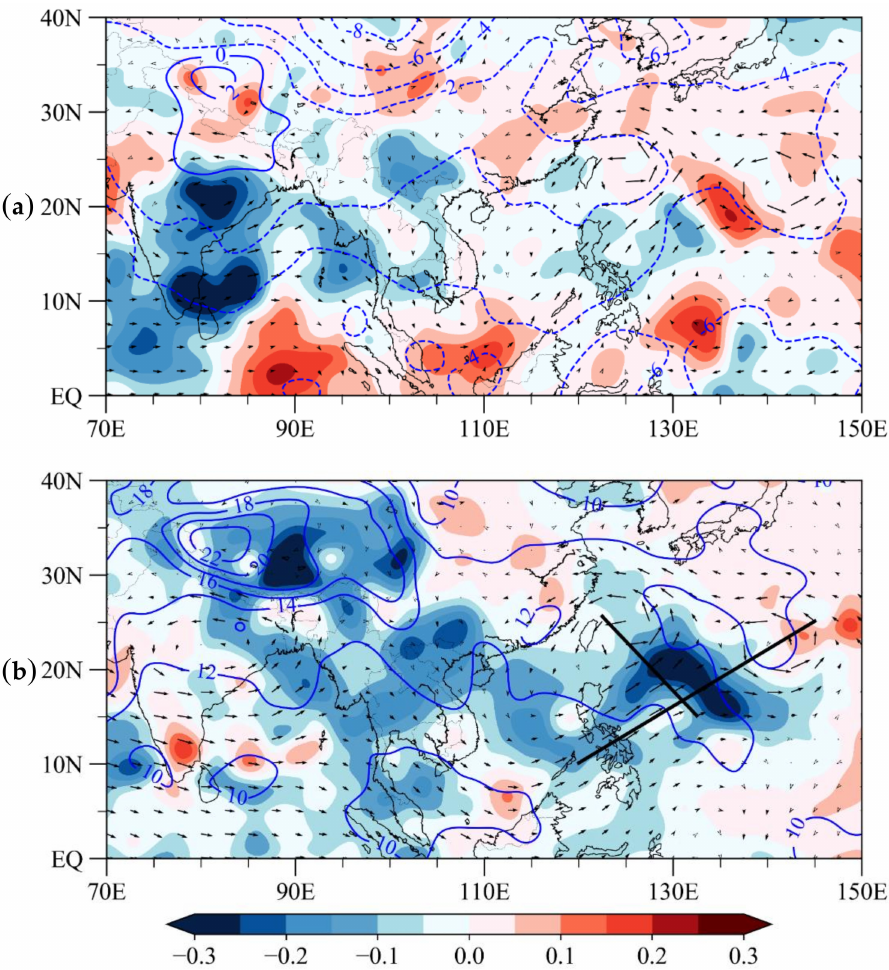
Figure 4. Spatial distribution of the air temperature (contours; units: ◦ C) and winds (vectors; units: m / s) at ( a ) 500 and ( b ) 700 hPa for the ODS experiment at 0900 UTC 8 August 2019. The shading represents the di ff erence in the air temperature between the two experiments (ODS − CTRL; units: ◦